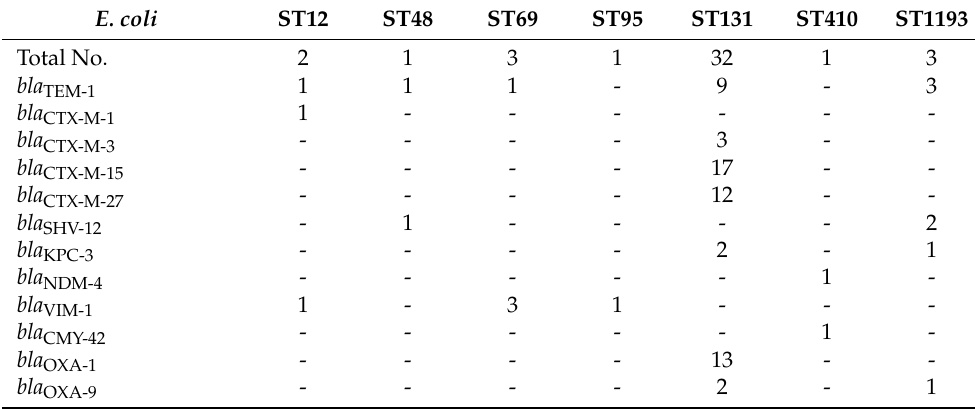
Table 4. Distribution of β -lactamase genes among E. coli